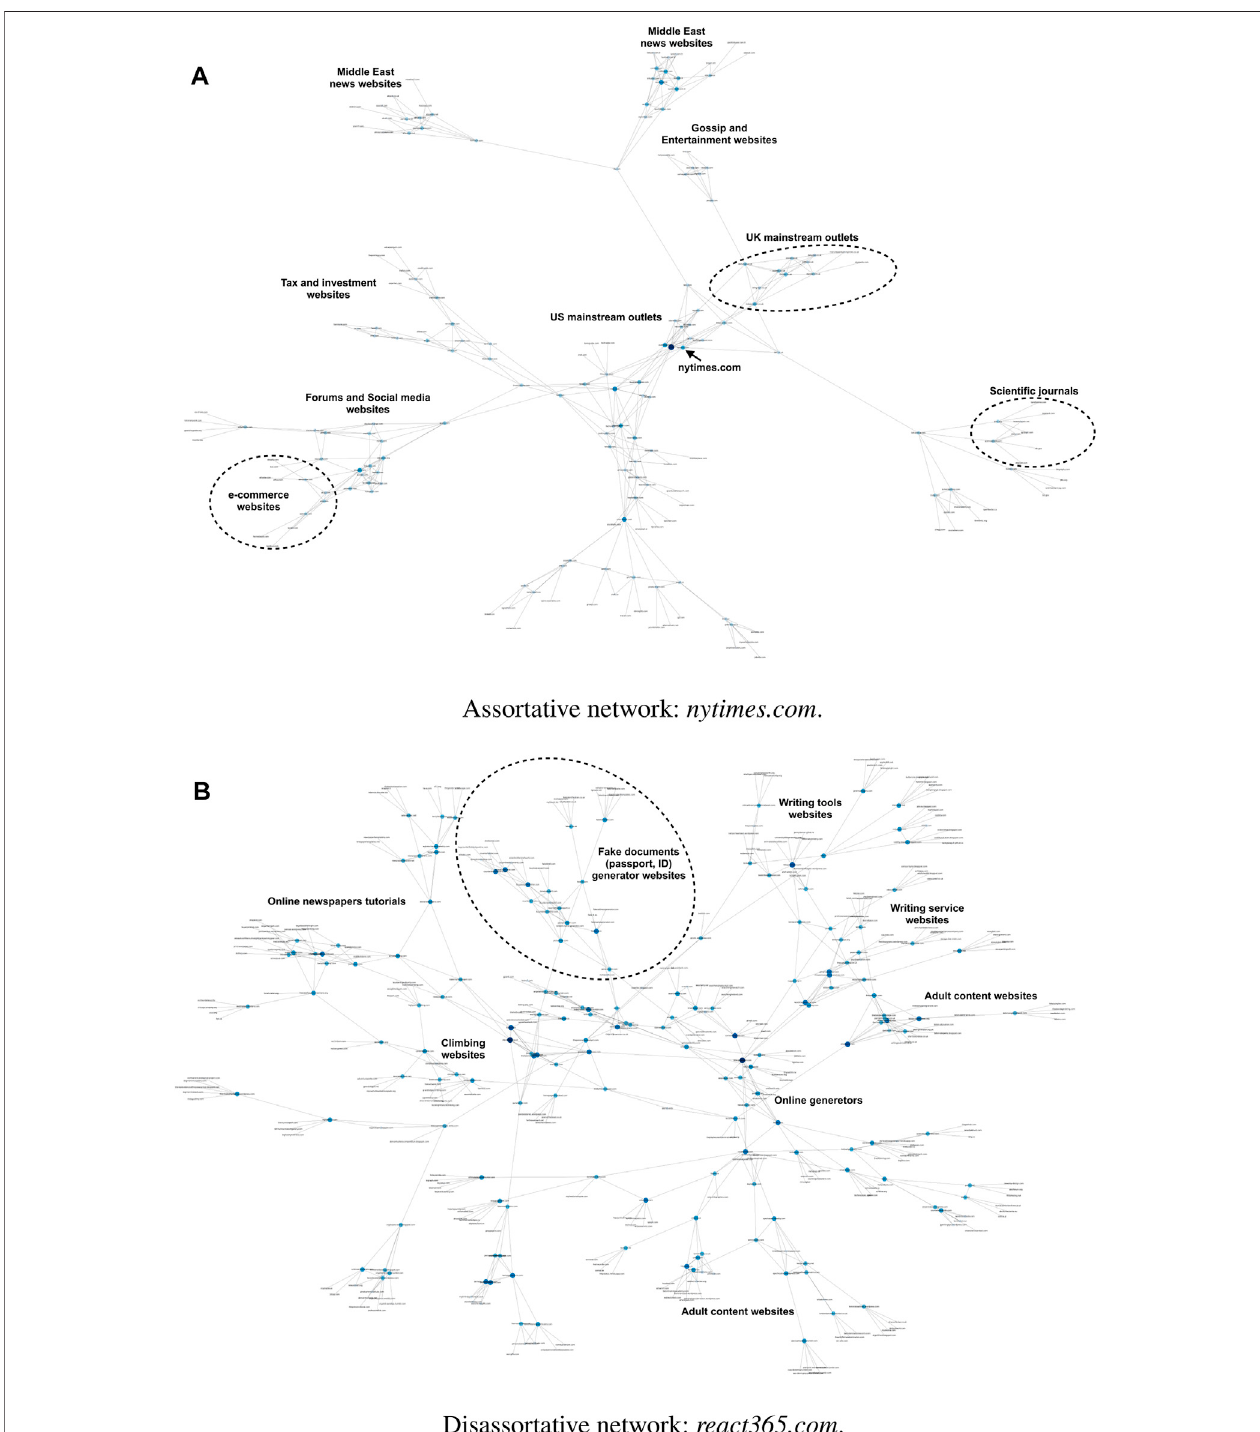
FIGURE4| Exampleofassortativeanddisassortativereal-worldnetworks.Thenode ’ ssizedependsonthenode ’ sdegree.Also,thecolordependsonthedegree using a sequential blue color map: the darker the node ’ s color, the higher the node ’ s degree. The sub-network in (A) is connected and there are no isolated nodes. The sub-network in (B) shows only the connected component (the standalone nodes are hidden). Most sub-networks, built from unreliable news sources, have isolated nodes, that is, websites for which there is no information on the overlap of the audience with other websites. These sub-networks exhibit disassortative behavior: this means that high degree nodes are less connected to each other.